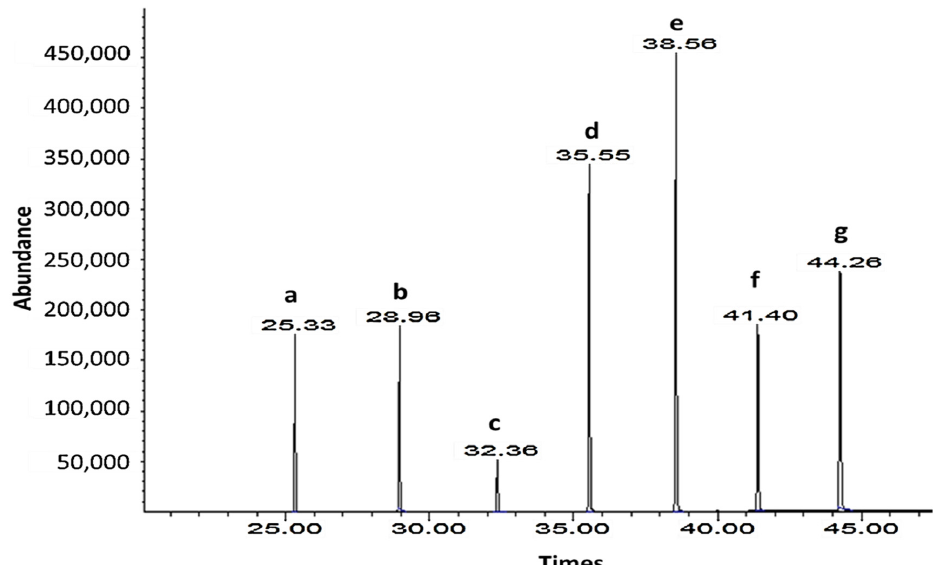
Figure 3. GC-MS chromatograms of standard policosanol at 100 ppm: a. Docosanol (C-22); b. Tetra- cosanol (C-24); c. Hexacosanol (C-26); d. Octacosanol (C-28); e. Triacosanol (C-30); f. Dotriacontanol (C-32); g. Tetratriacontanol (C-34). The results also showed that both the policosanol and phytosterol contents of crude extracts from all the by-products by SUBLDME extraction were significantly higher than the solvent after Soxhlet extraction (Table 3). With the highest extraction yield, sugarcane leaves extracted by SUBLDME provided the highest policosanol content (2845.71 mg/100 g) followed by bagasse (2446.82 mg/100 g). Although the bagasse gave the lowest yield percentage (2.95%) compared with filter mud (4.26%), the policosanols contents of bagasse (2444.29 mg/100 g) were remarkably higher than that of filter mud (668.90 mg/100 g) by SUBLDME. For an efficient extraction process, it is important that the cell wall is permea- ble and can be extensively disrupted. Plant tissue is generally compartmentalized. Differ- ent bioactive components are located in different parts of the cellular tissue and the tissue structure plays an important role in the release of chemical components [43]. For the same extraction method using different samples, the extraction yield and the released bioactive contents from solid–liquid extraction depend on many parameters. The crucial factor is the solid matrix of samples, especially the microstructural effect. The different solid ma- trices of sugarcane leaves, bagasse, and filter mud caused diverse diffusivity as a result of structural complexity impacts such as tortuosity, porosity, and volume fraction [43,44]. By fluorescence microscopy (OLYMPUS, Model BX53F2, Tokyo, Japan), the outermost layers of the sugarcane leaves after SUBLDME were seen to be slightly damaged and displayed wrinkles intermittently (Figure S1). There was a rougher surface and some round particles that were exposed on the surface of it, indicating that the surface was significantly dam- aged, and the round particles almost disappeared. Bao et al. [45] found a similar result after extraction of lotus seedpods by gas-assisted, glycerol extraction [45]. For supercritical fluid CO 2 extraction (SF-CO 2 ) at 35 MPa and 50 °C, Attard et al. [15] found the total policosanol content of sugarcane leaves and bagasse at 613.7 and 913.6 mg/100 g, respectively. The policosanol contents found in this study were much higher, at 4.5 and 2.6 times, for sugarcane leaves and bagasse, respectively. Therefore, SUBLDME